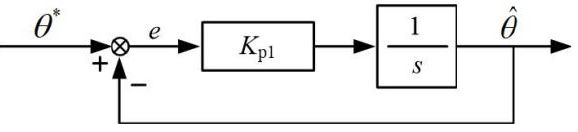
Figure 5. The equivalent block diagram of position loop. Figure 4 is the equivalent block diagram of the speed loop.